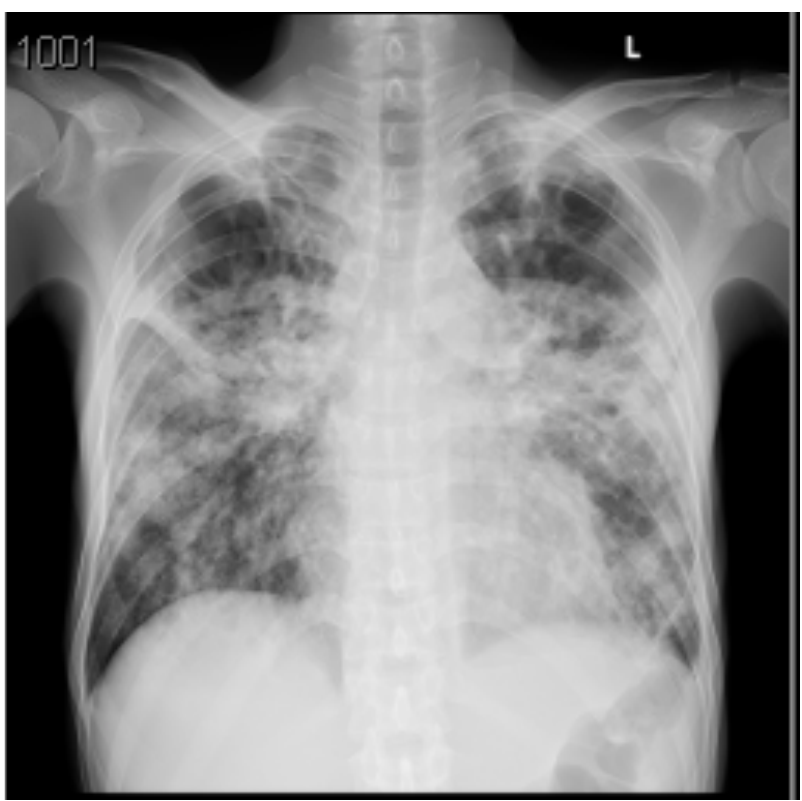
Figure 3. Posteroanterior chest X-ray (CXR) of the third case. The CXR shows diffuse bilateral reticular infiltration, mainly in the middle zones with bilateral apical cavitary lesions. The cardiac shadow and configuration are shaggy but generally show no abnormality, and the costophrenic angles are clear.